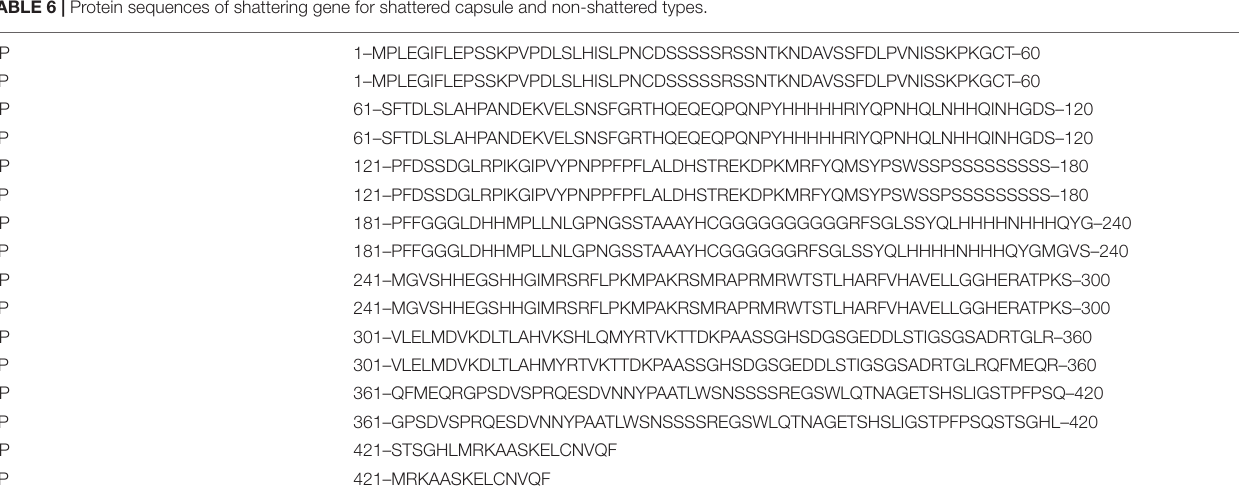
FIGURE 5 | Gene structure of the candidate gene controlling the shattering trait. One gene and six CDSs were predicted in capsule shattering (A) and non-shattering (B) parents. CDSf, first exon (starting with start codon); CDSi, internal (internal exon); CDSl, last coding segment; PolyA, polyadenylation signal. TABLE 6 | Protein sequences of shattering gene for shattered capsule and non-shattered